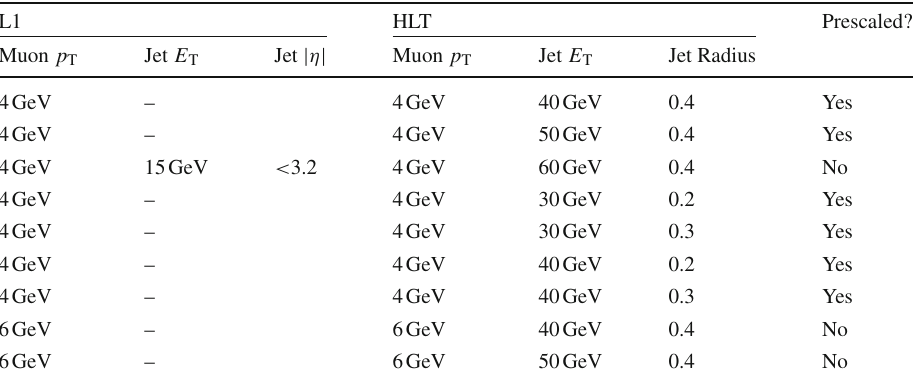
triggers and the values ranged from 1.0 (i.e. unprescaled)